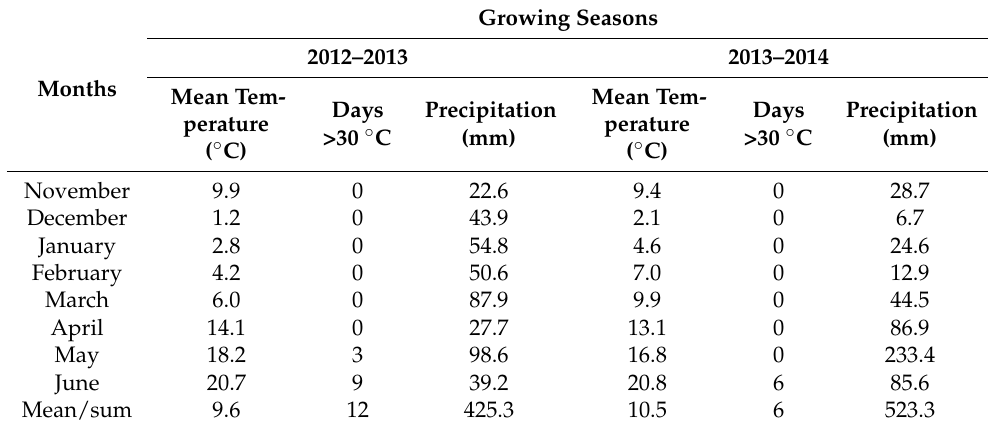
Table 2. Weather conditions during two winter wheat growing